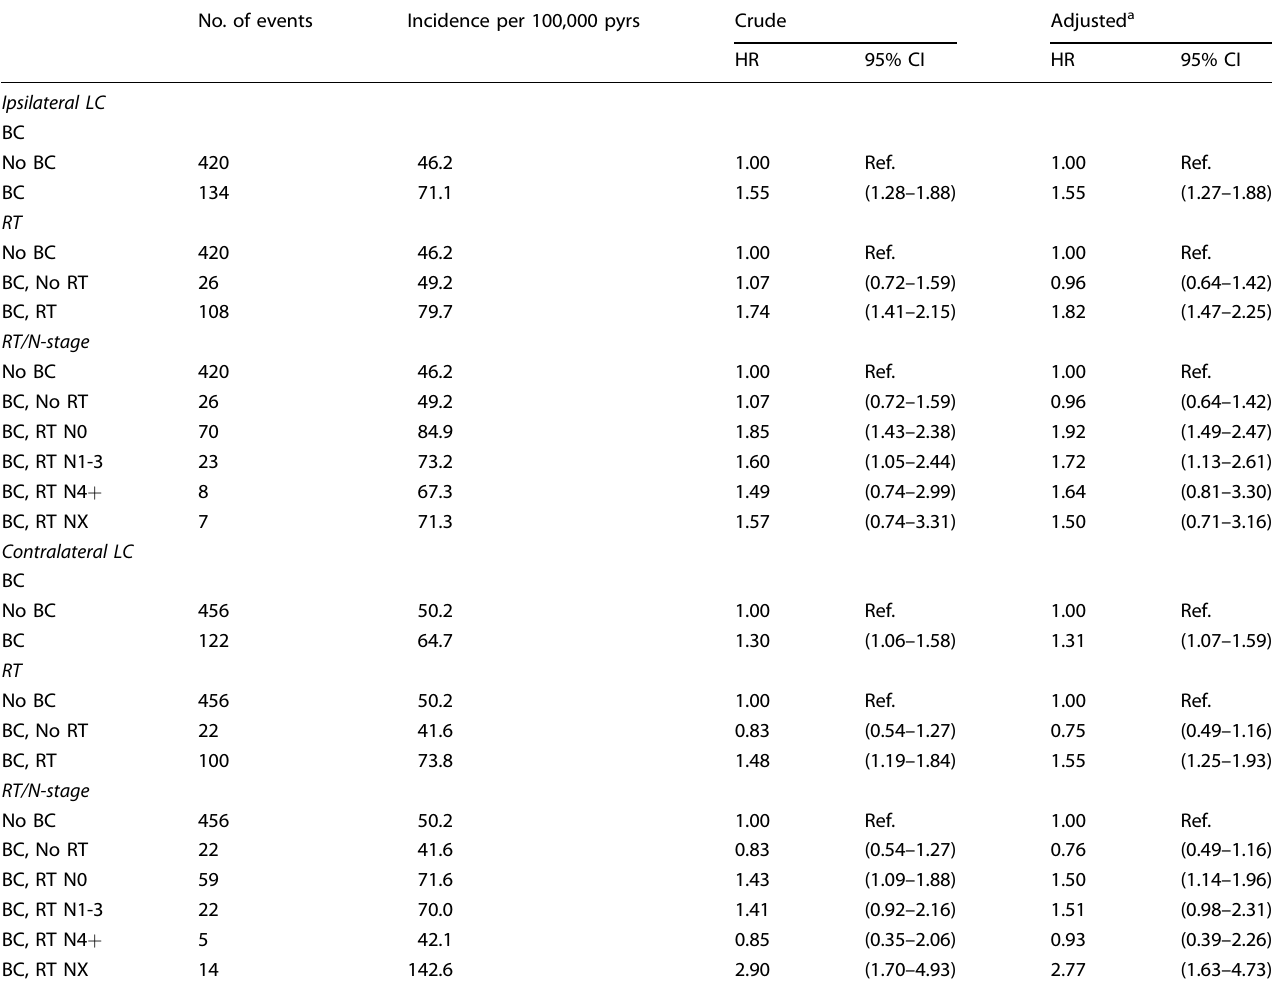
Table 2. Risk of ipsi- and contralateral lung cancer in women with breast cancer compared to women without breast cancer diagnosis. No. of events Incidence per 100,000 pyrs